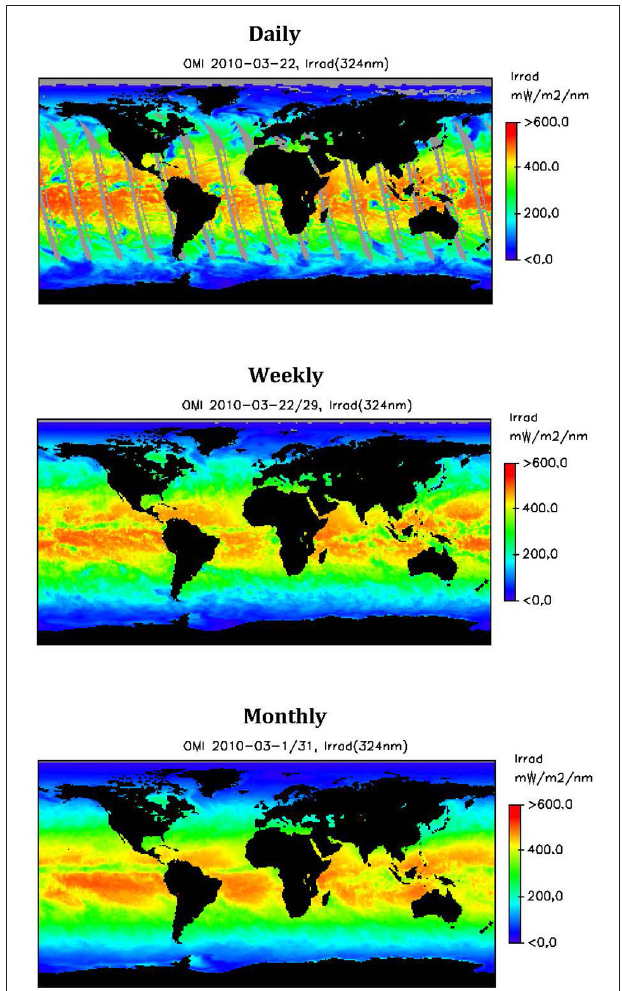
FIGURE 3 | Daily, weekly and monthly noon above-surface UV irradiance at 1 ◦ resolution, derived from OMI-Aura. Top : March 22, 2010; Middle : March 22–29, 2010; Bottom : March 1-31, 2010. (From NASA GES DISC).